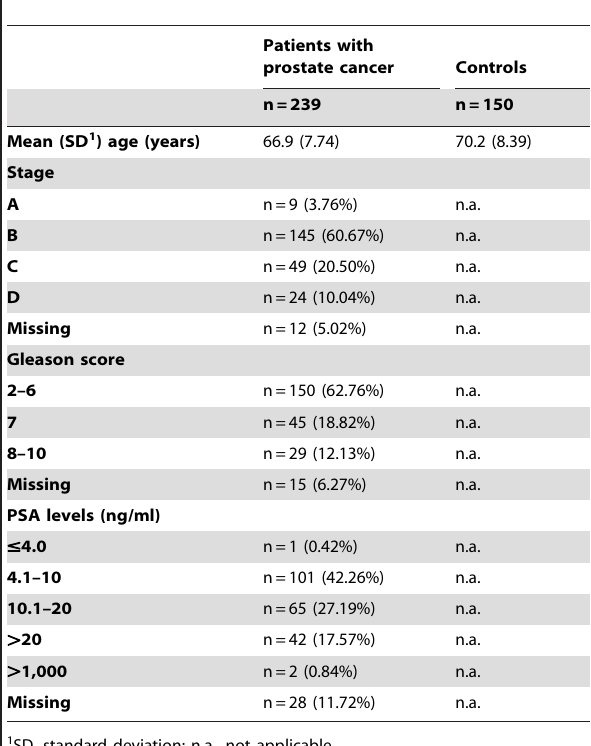
Table 1. Characteristics of the study population.